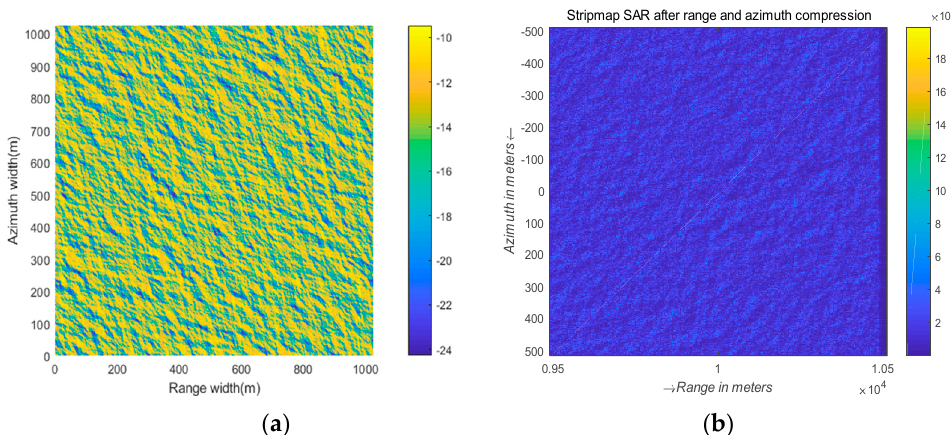
Figure 7. Networked SAR satellite observations of the same sea area.